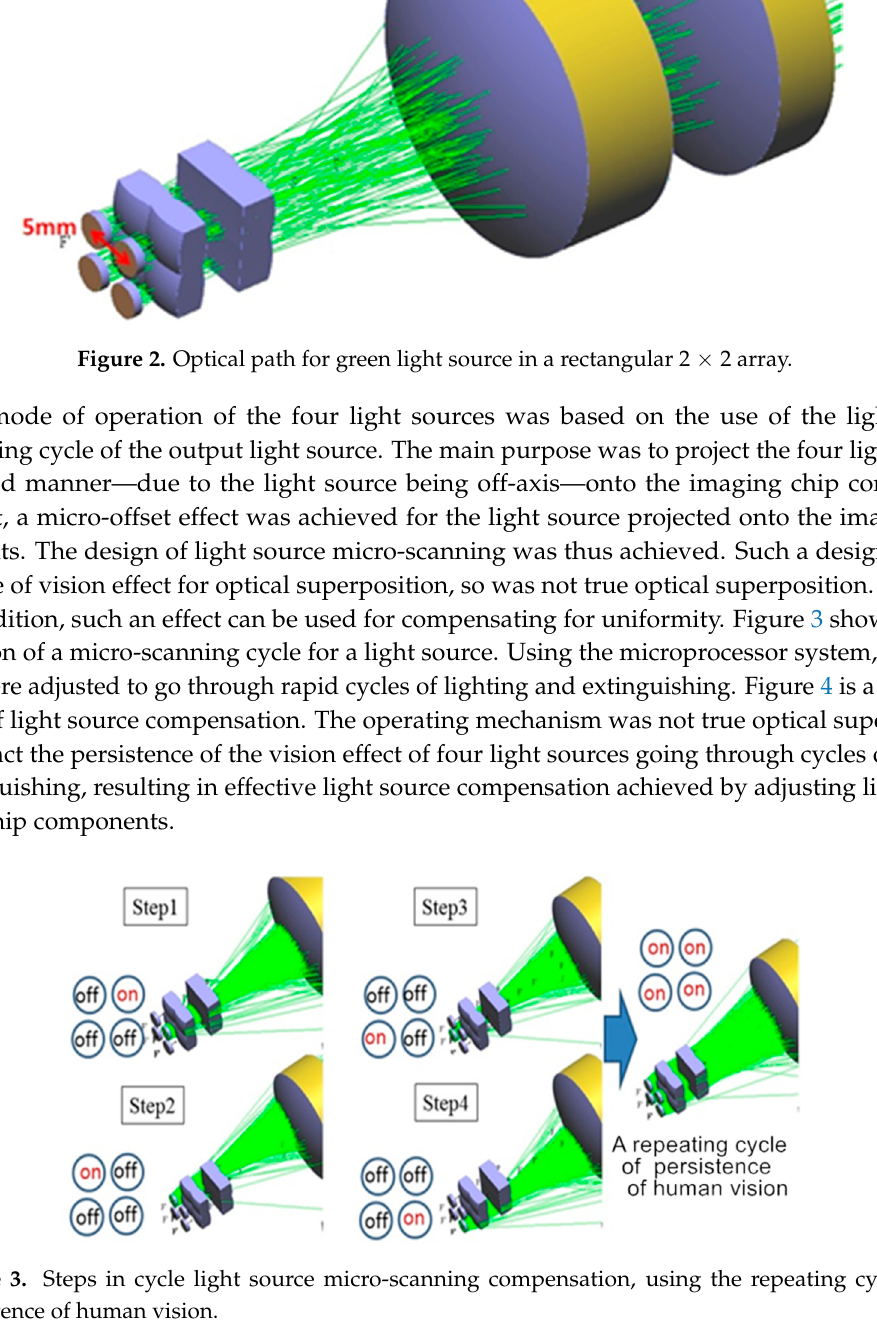
Figure 1. Micro-scan compensation technology enhances the pixels.